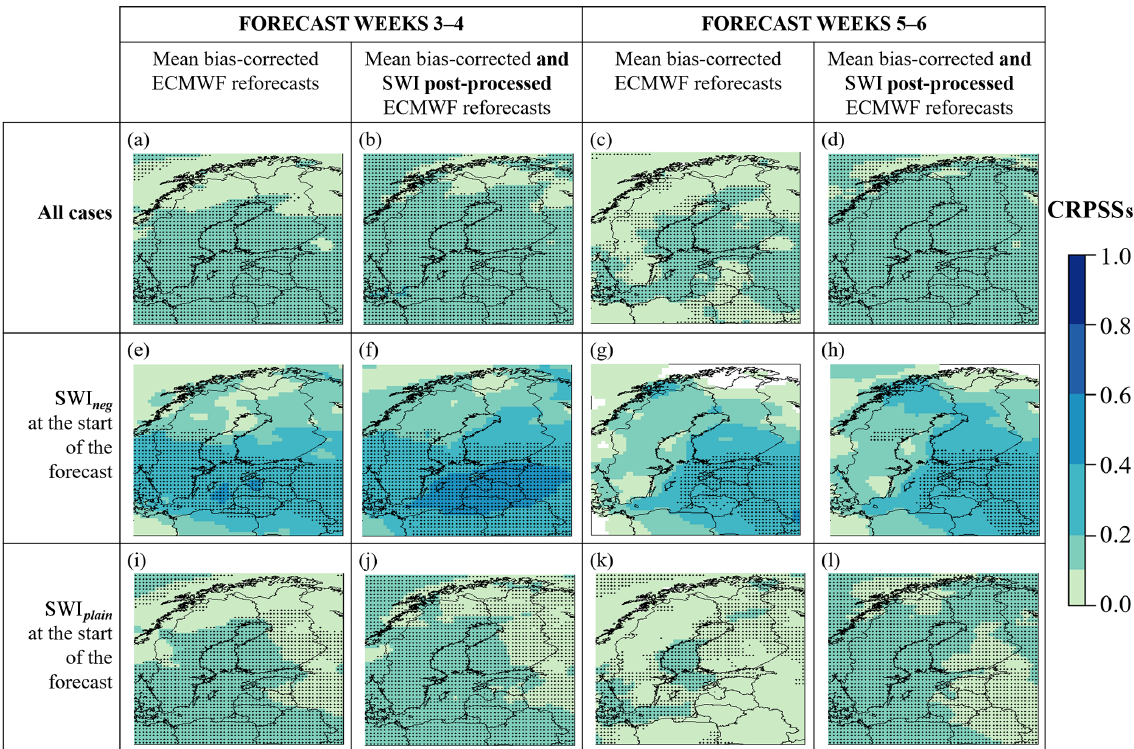
Figure 5. Expected CRPSSs of forecast weeks 3–4 and 5–6 of the ECMWF’s 2-week mean temperature reforecasts for November–February 1997–2016 in all cases (a–d) , after SWI neg (e–h) , and after SWI plain (i–l) , with mean bias correction only (a, c, e, g, i, and k) and with both mean bias correction and SWI-based post-processing (b, d, f, h, j, and l) . ERA-Interim climatology of 1981–2010 was used as the reference. The dotted areas represent the 95% level of confidence that the CRPSS is above